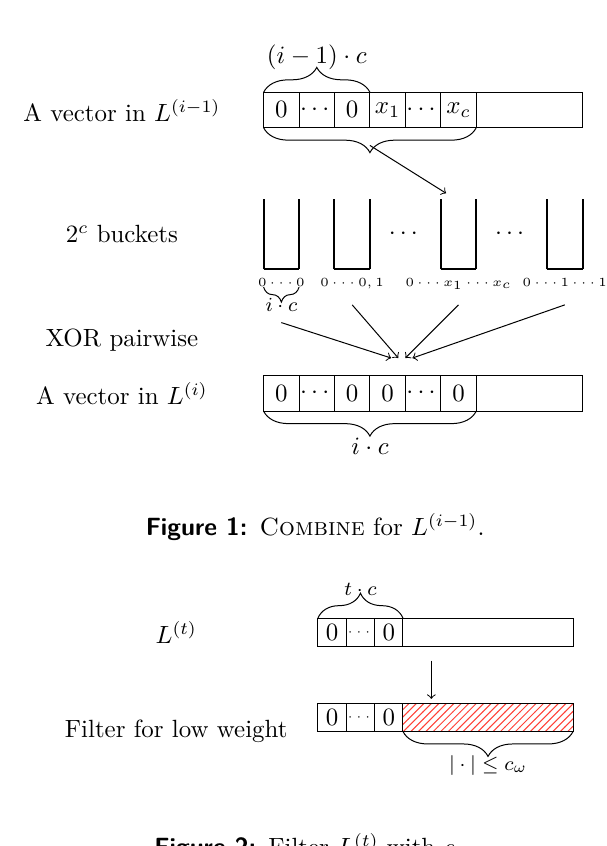
Figure 2: Filter L ( t ) with c ω